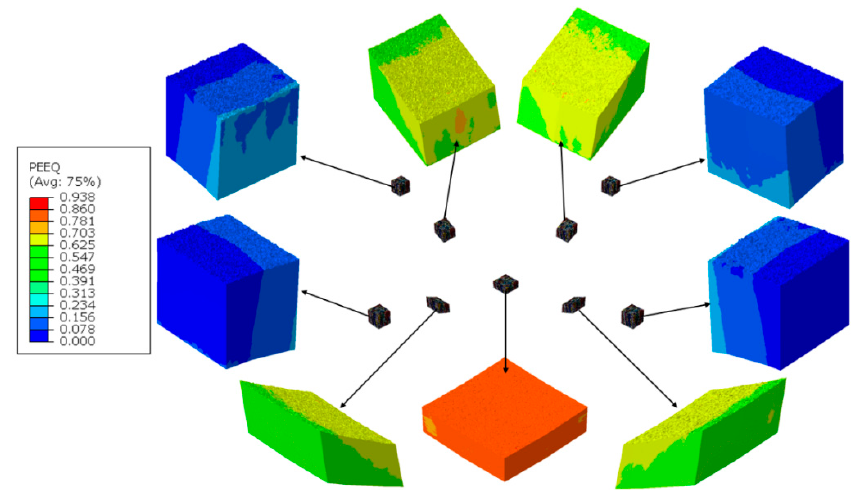
Figure 13. Equivalent strain distribution in the DMR model after nanoindentation test.